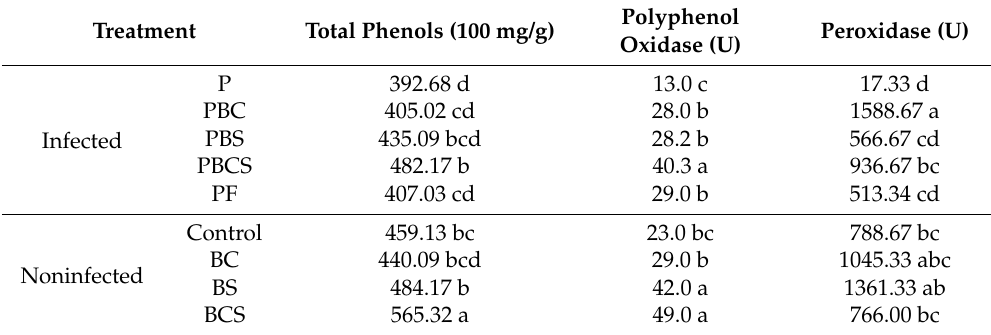
Table 6. Physiological characteristics of fenugreek as affected by endophyte Achromobacter sp. F23KW treatments under greenhouse conditions and Rhizoctonia solani